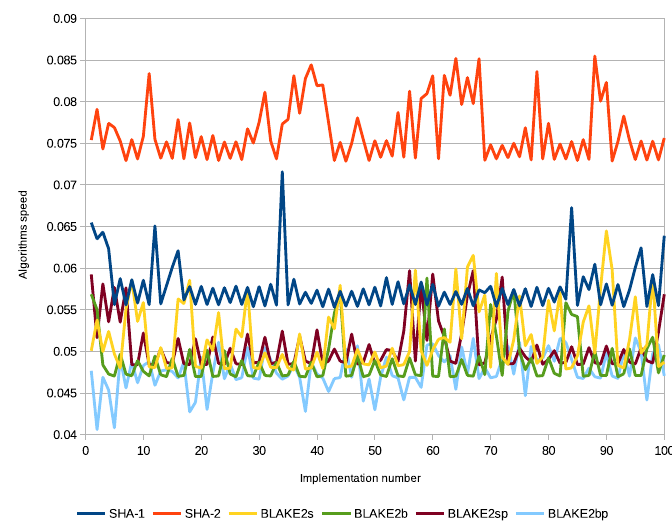
Figure 17. Comparison of SHA and BLAKE2 with 1 MB data.